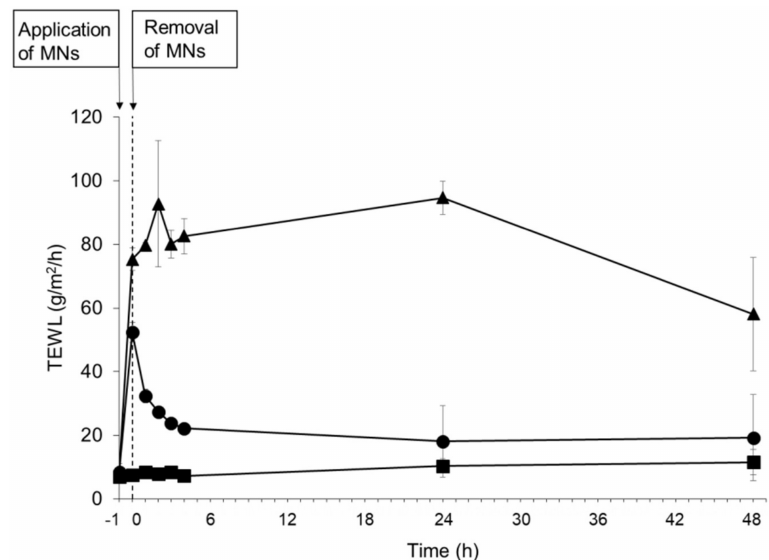
Figure 4. Effects of human parathyroid hormone (1-34) (PTH)-loaded microneedle arrays (MNs) application on transepidermal water loss (TEWL) of rat skin in vivo. Keys: ( ) PTH-loaded MNs, ( (cid:78) ) tape stripping treatment, and ( (cid:4) ) intact skin. Results are expressed as the means ± standard deviation (SD) of three